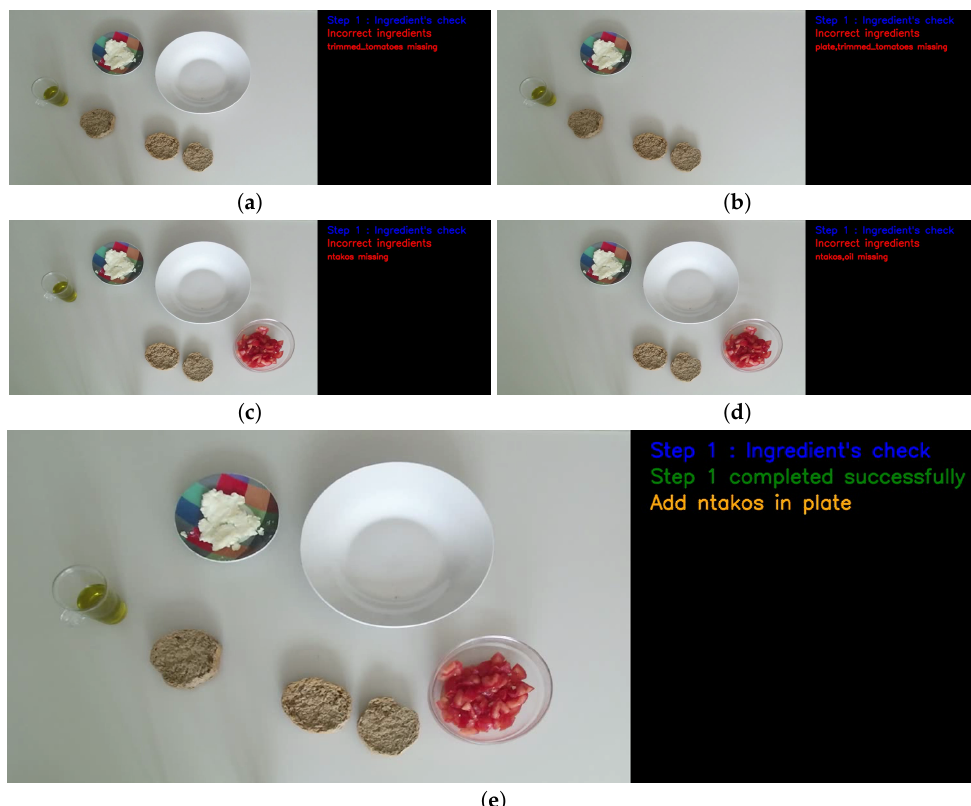
Figure 11. The process of checking for the correct ingredients: ( a ) tomatoes missing, ( b ) plate and tomatoes missing, ( c ) ntakos missing, ( d ) ntakos and oil missing, ( e ) all the ingredients are